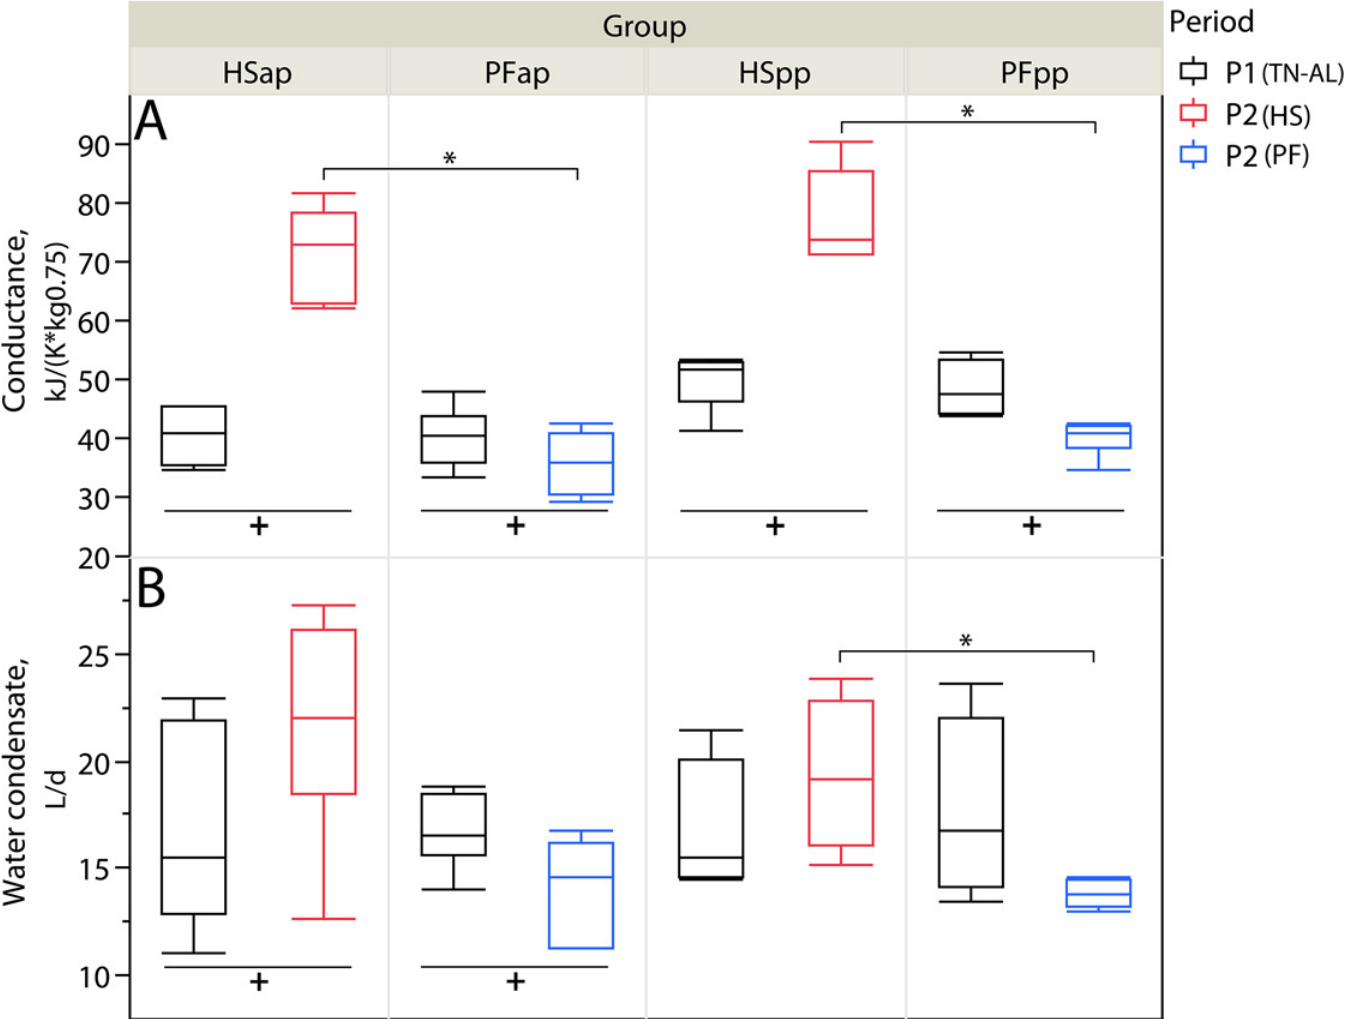
Fig 5. Conductance and Water Condensate. Effect of heat stress (HS) and pair-feeding (PF) on (A) conductance and (B) water condensate. In experimental period 1 (P1, black) all animals were kept at thermoneutral conditions (TN, THI = 59.7) with ad-libitum feeding (AL) for six days. During period 2 (P2), HS cows (red) were heat-stressed (THI = 76.1), whereas PF cows (blue) were pair-fed in thermoneutrality (THI = 60.0) for six days, once ante partum (ap) and again post-partum (pp). Data acquired during the 24-hour indirect calorimetry analysis on day 5 of each period. (A) For conductance analysis, numbers of animals analyzed per group: HSap n = 7, PFap n = 6, HSpp n = 6, PFpp n = 6; (B) For water condensate measurement, numbers of animals analyzed per group: HSap n =, 6 PFap n = 6, HSpp n = 4, PFpp n = 4; + P < 0.05 in Wilcoxon signed rank sum test for paired samples of the same group; there were no differences in groups of the same reproductive stage in P1 (P > 0.05) according to the exact Wilcoxon-Mann-Whitney test; * P < 0.05 in the exact Wilcoxon-Mann-Whitney test for group differences of the same reproductive stage in